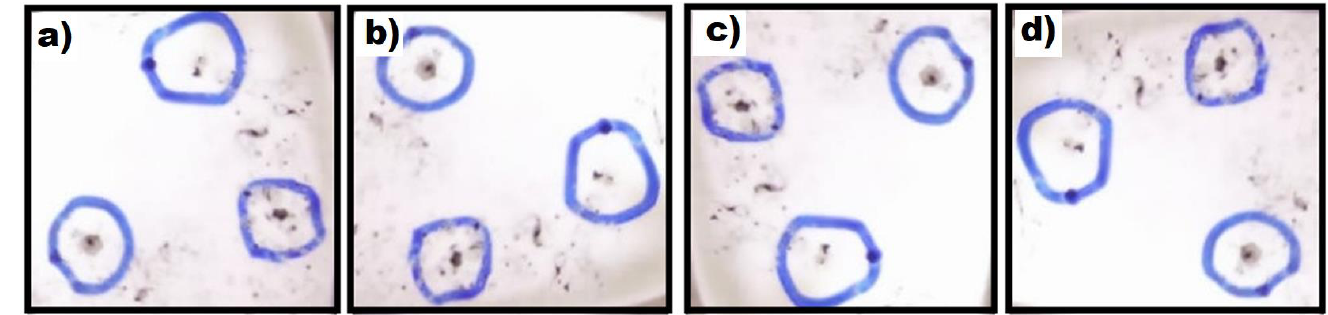
Figure 13. Images of indentations on micro hardness test specimens with ( a ) 0% ( b ) 5% ( c ) 10% ( d ) 15% ZrO 2 particulates reinforced with 13 wt.% Si.